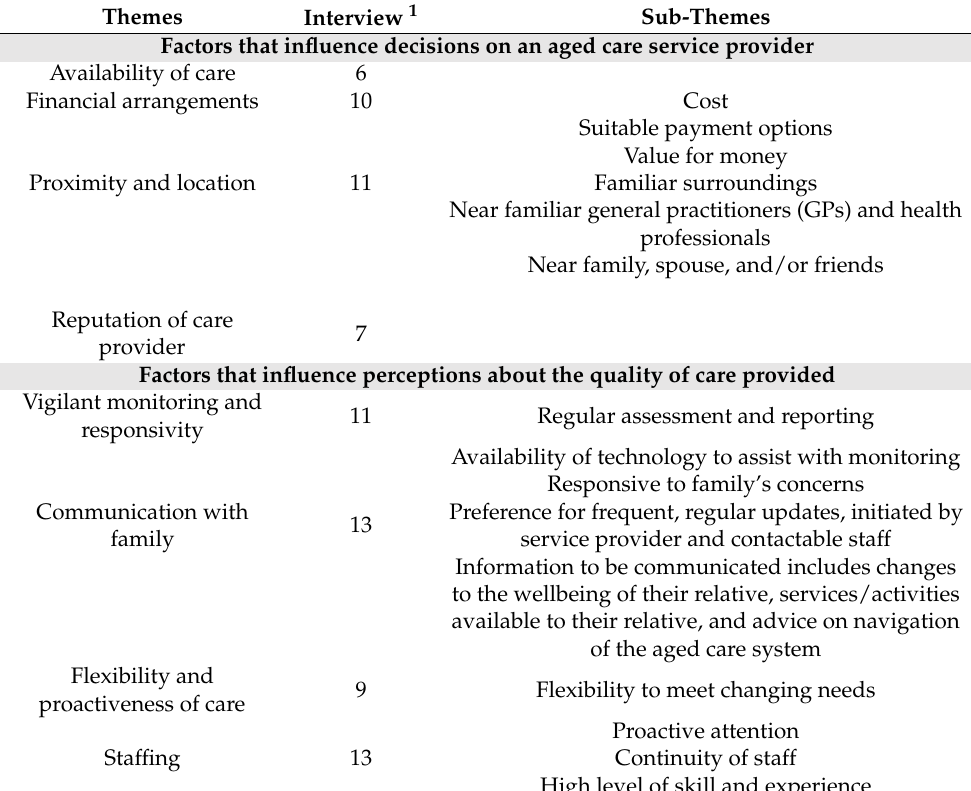
Table 2. Thematic coding